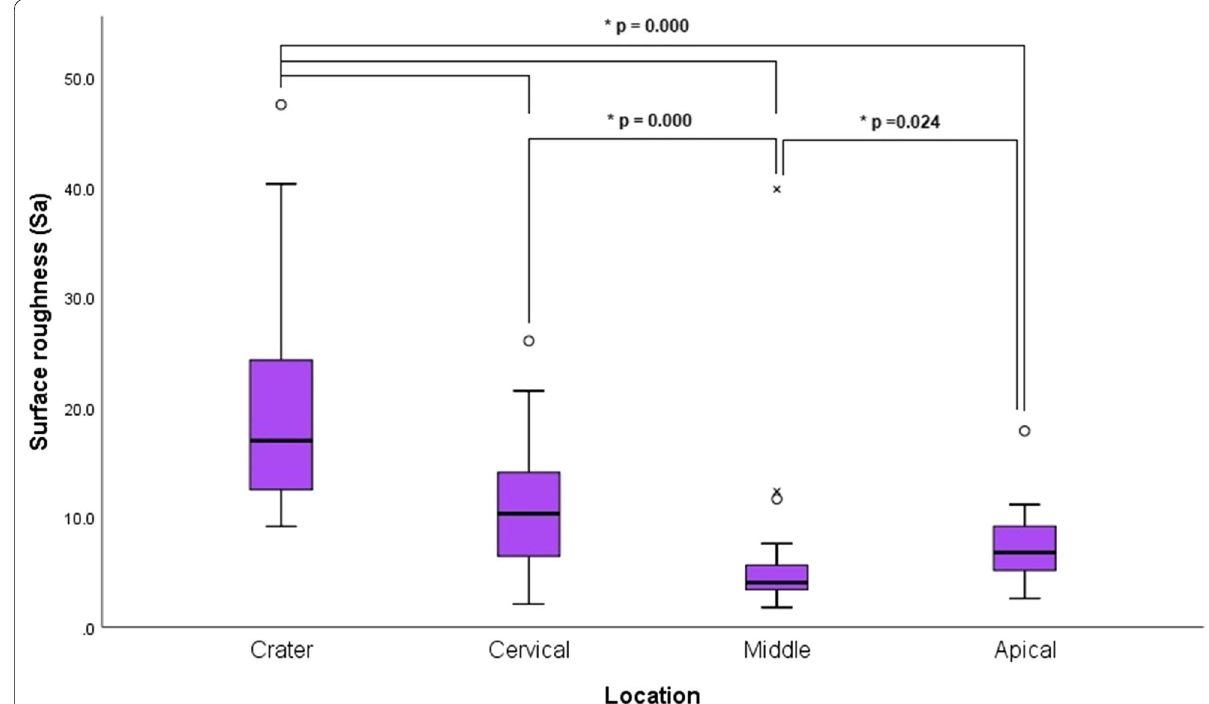
Fig. 5 Box plot for surface roughness at different locations